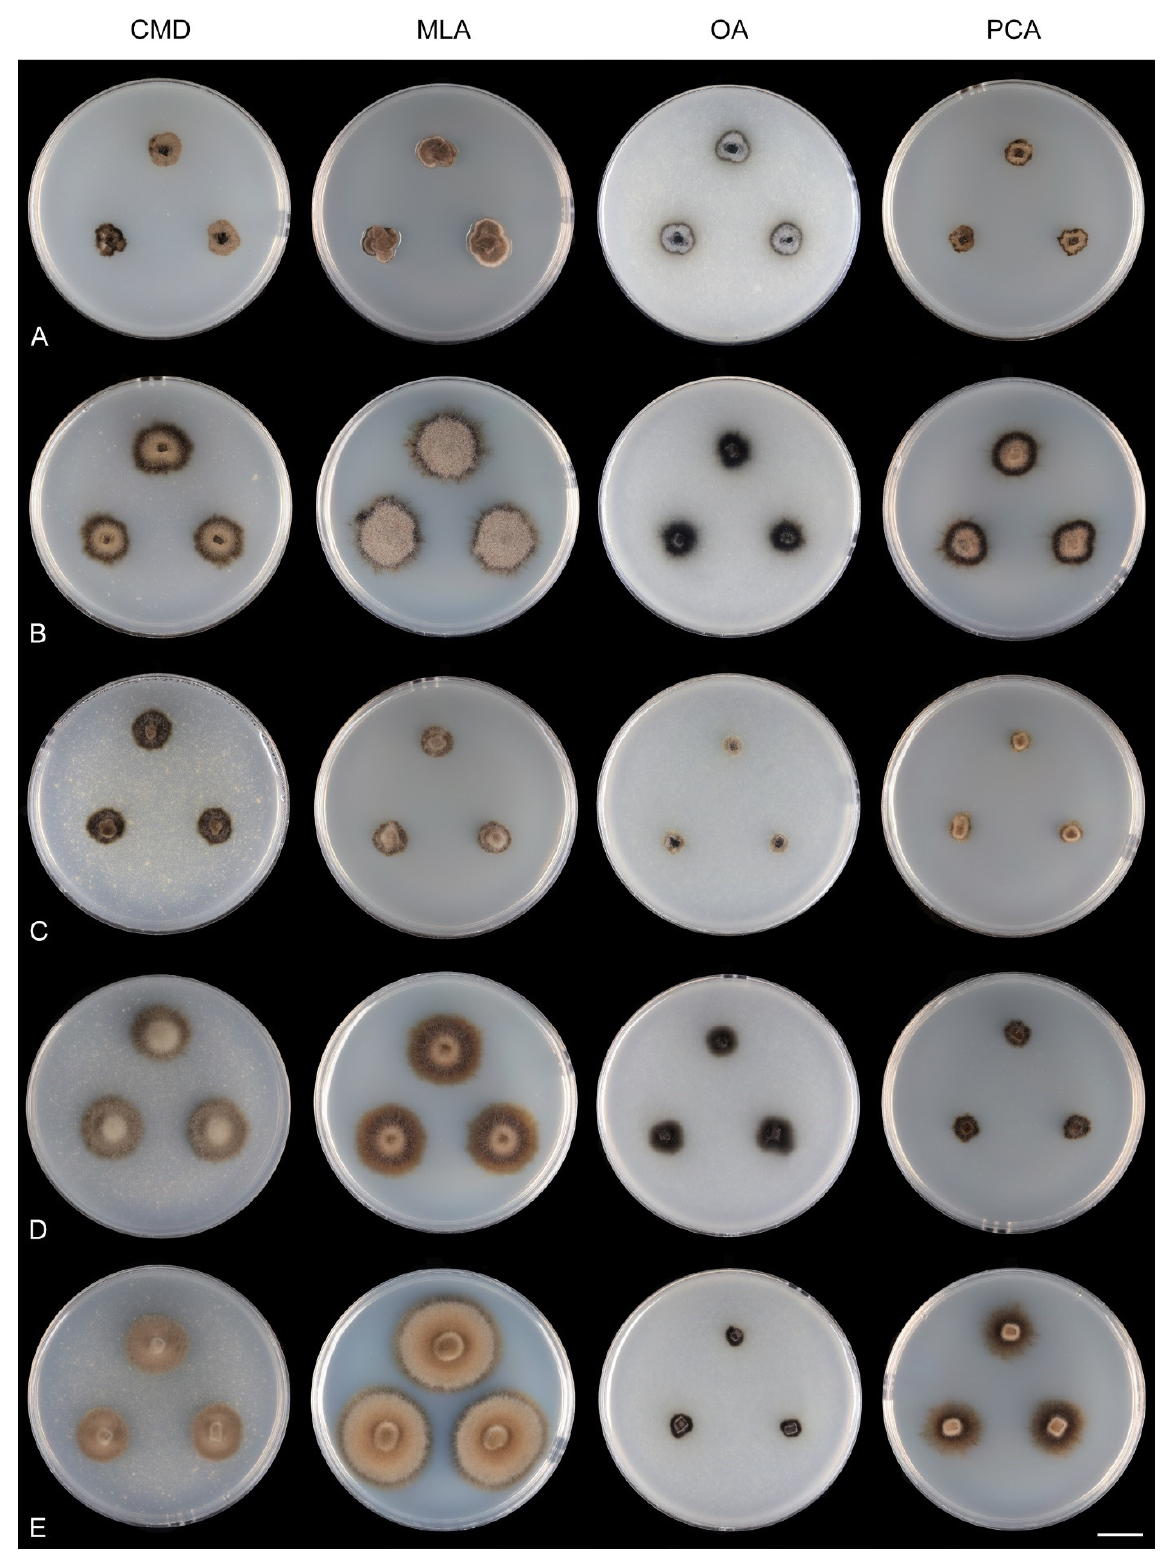
Figure 9. Colony morphology of Zanclospora on CMD, MLA, OA and PCA after 4(–6) weeks. ( A ) Z. aurea ICMP 23703 (6 weeks). ( B ) Z. lateriphiala CBS 147014 (4 weeks). ( C ) Z. phaeostalacta ICMP 15137 ex-type (4 weeks). ( D ) Z. ramifera ICMP 15127 (4 weeks). ( E ) Z. xylophila ICMP 22737. Bar: ( A – E ) = 1 cm.